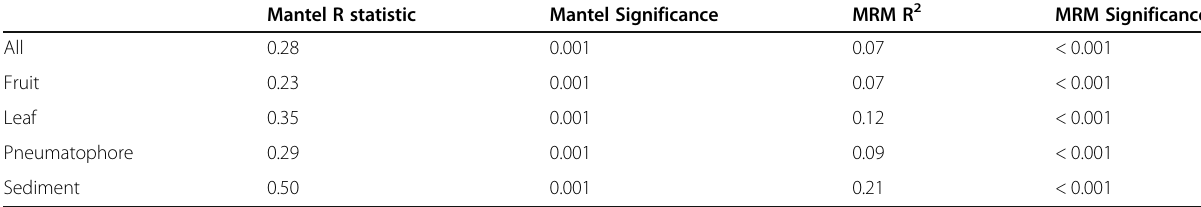
Table 1 Mantel test and multiple regression on distance matrices (MRM) results for all compartments combined, and each individual compartment. All show a significant pattern of distance decay Mantel R statistic Mantel Significance MRM R 2 MRM